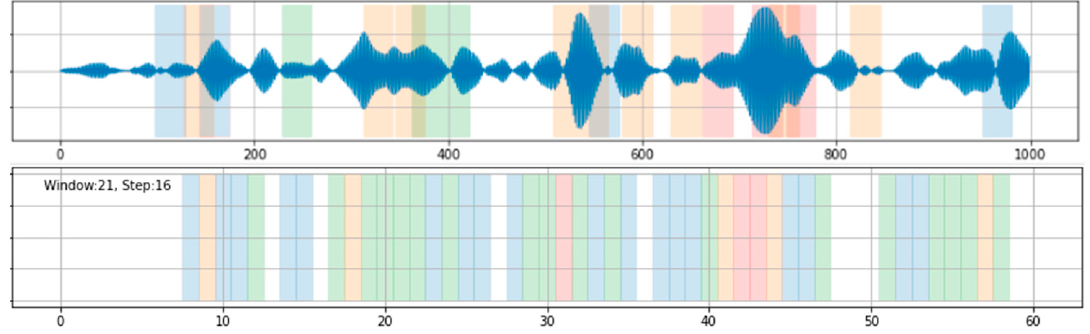
Figure 7. Classification results from k -means with various window sizes and step sizes for k = 5. A compromised solution is to only detect defects at a given location and classify them into one of two types: narrow spikes, or long-spanning blocks. In such a configuration, only three categories (narrow spikes, long-spanning blocks, and without a defect) would suffice and, as such, k is set to be 3. Furthermore, the feature vector for each sliding window includes the robust measure